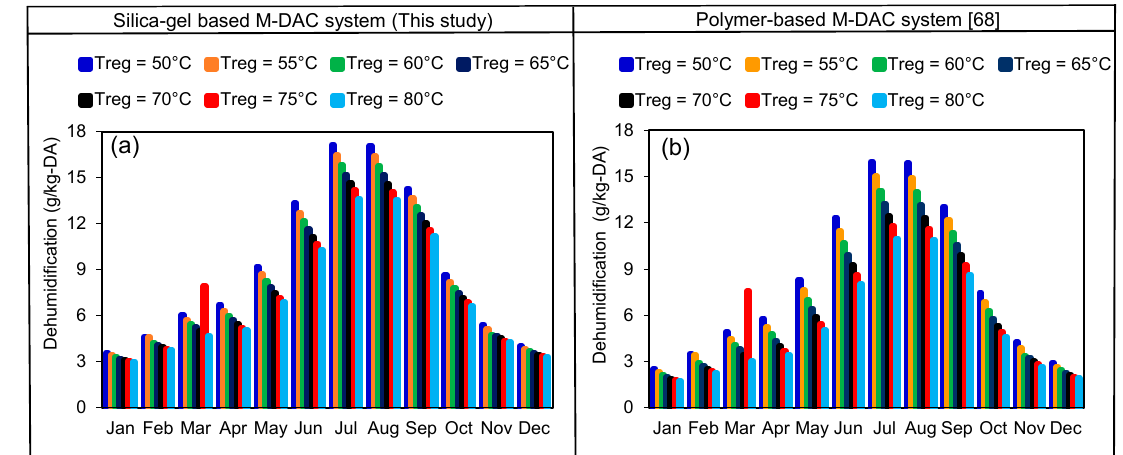
Figure A1. Dehumidification capacity of ( a ) silica-gel-based DAC system and ( b ) polymer-based DAC system at different regeneration temperatures.